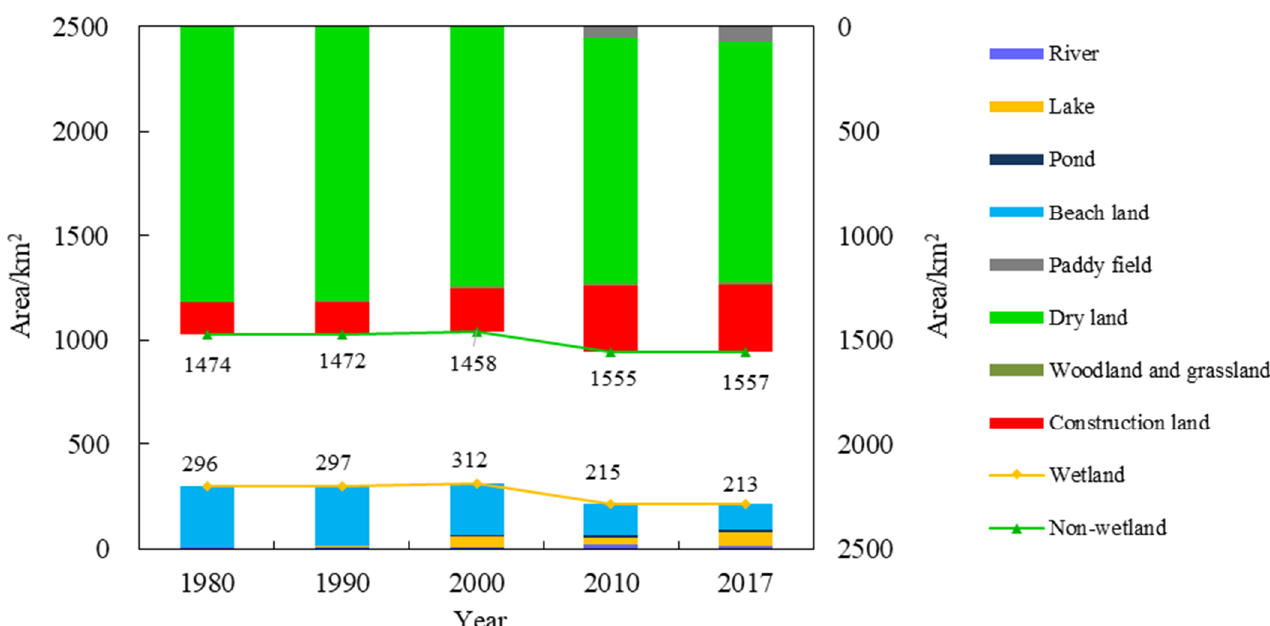
Figure 2. Changes in the area of the landscape types in the Xiong’an New Area from 1980 to 2017.